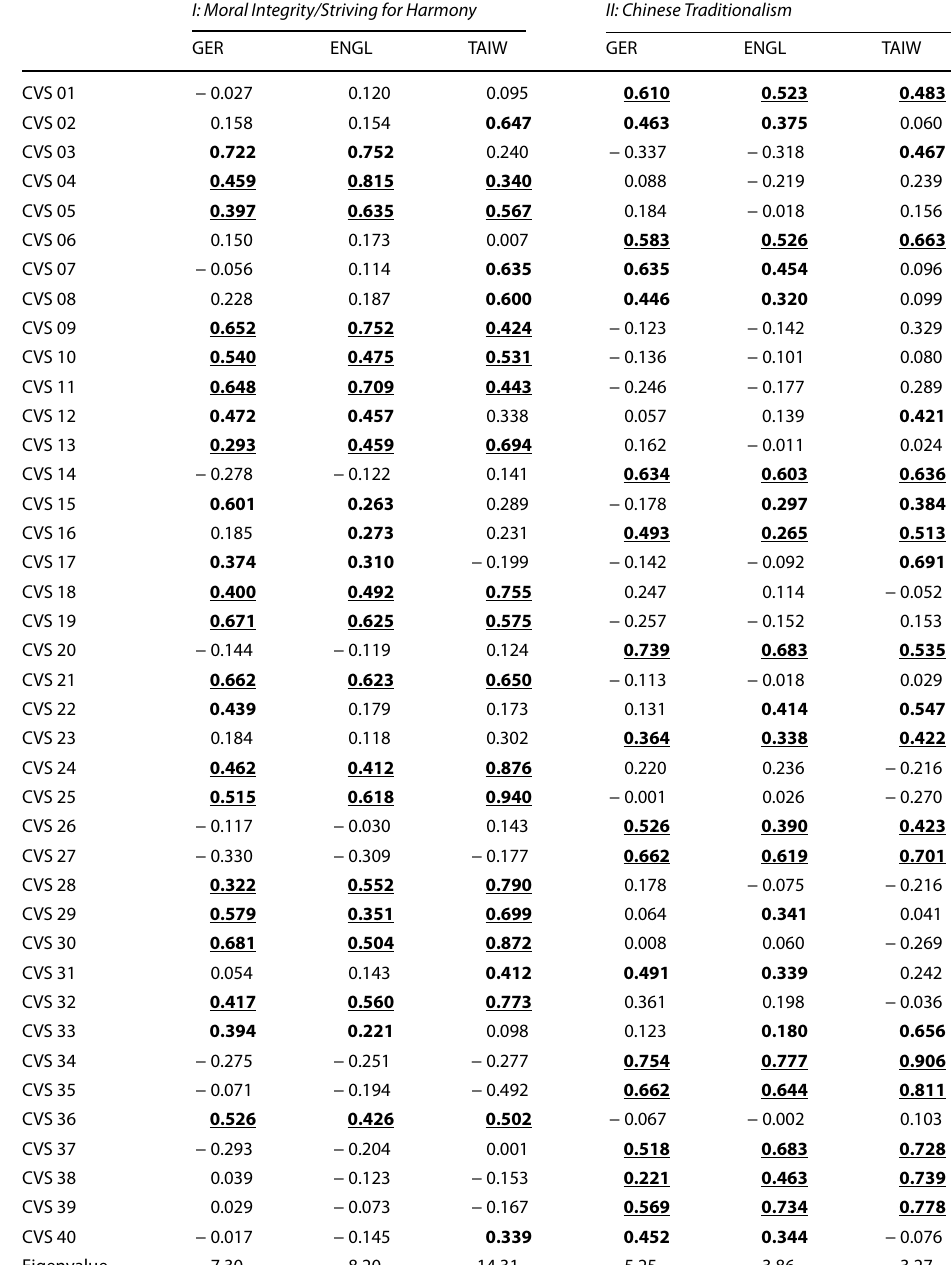
Table 1 Results of the principal component